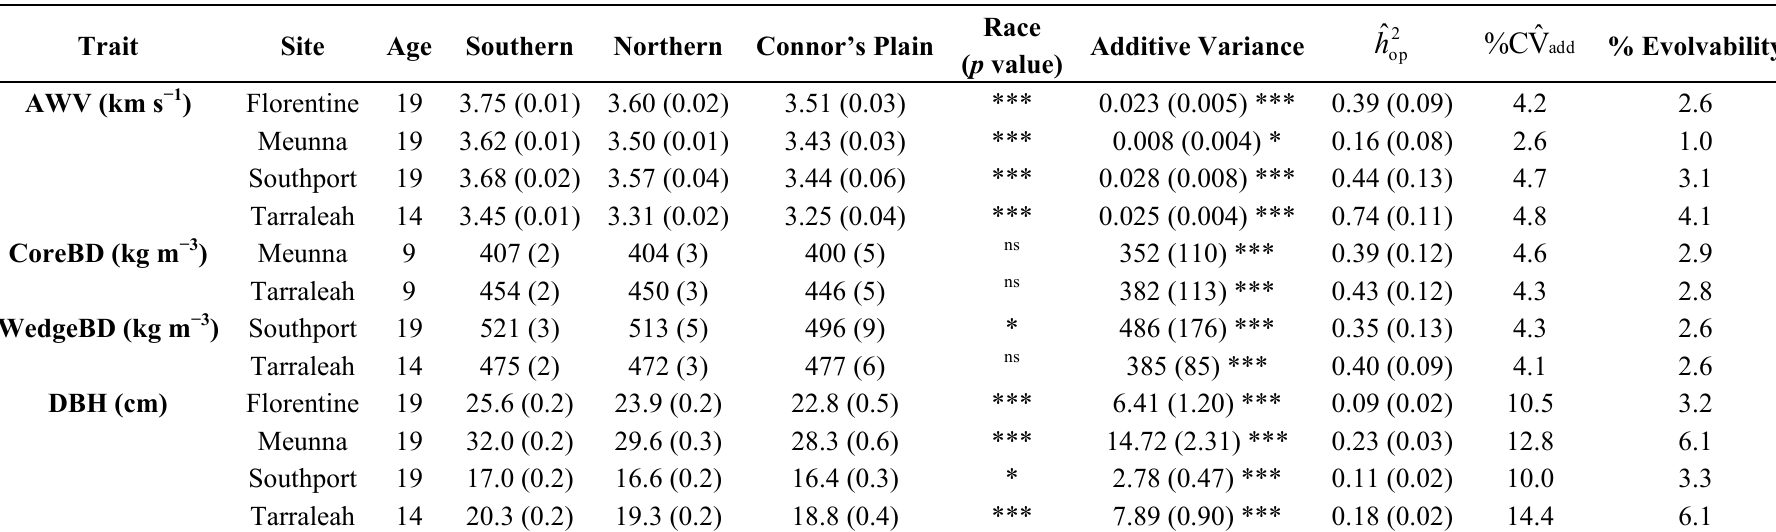
Table 4. Estimated race means, significance of the difference among races, within-race additive variance, narrow-sense heritability ( ) and coefficient of additive variance